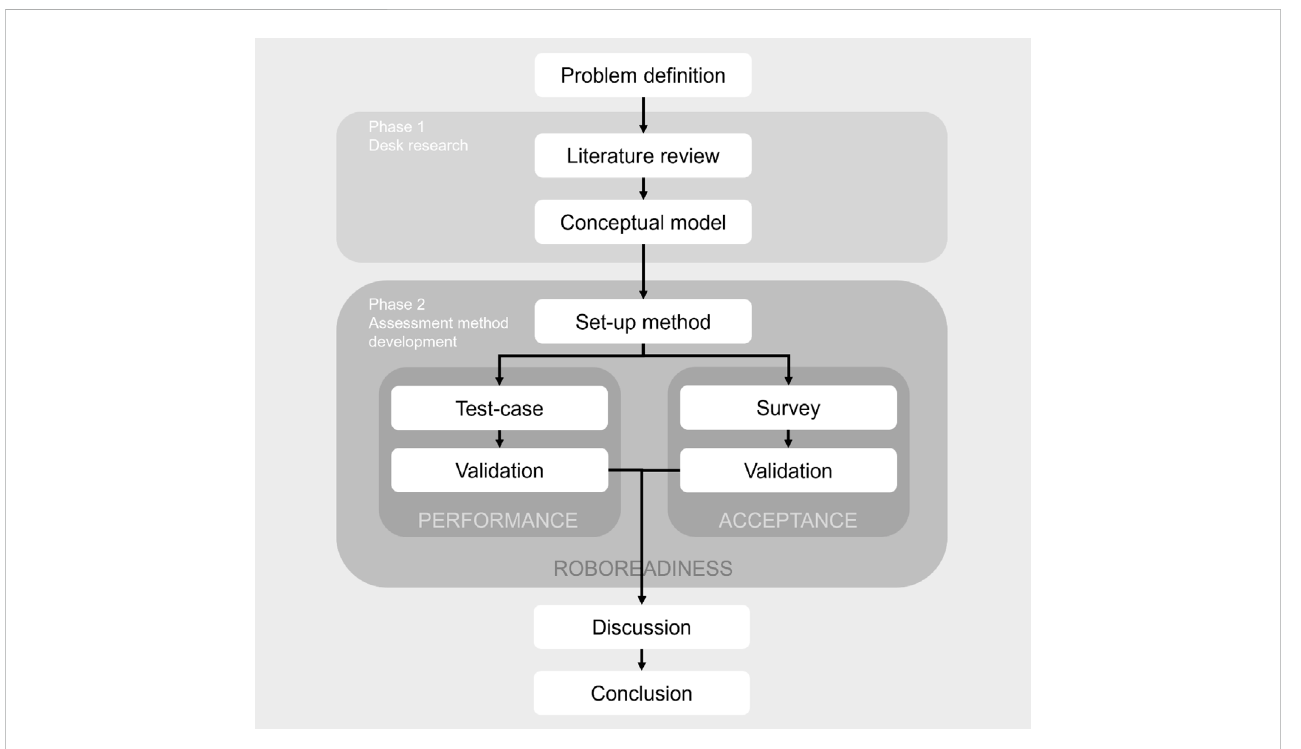
FIGURE 1 Research Approach to develop the Roboreadiness assessment